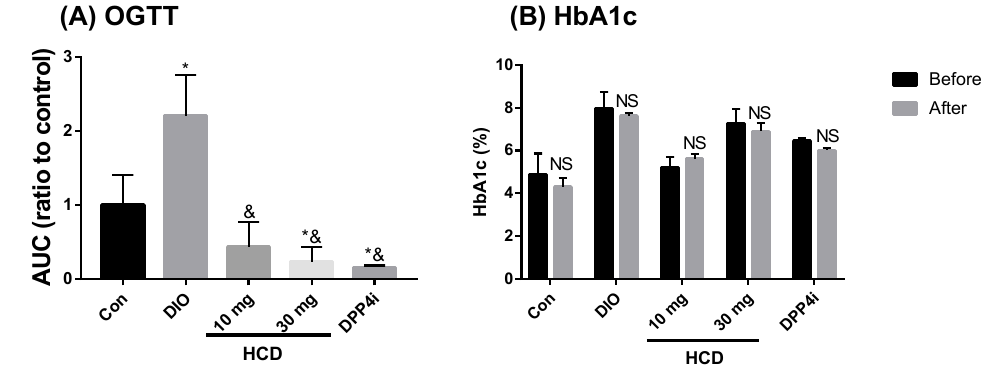
Figure 6. Insulin tolerance and glycated hemoglobulin (HbA1c) levels after long-term administration of natural compounds. DIO mice were fed with natural compounds for 5 weeks and insulin tolerance measured through ( A ) OGTT and ( B ) HbA1c levels. All results were mean ± SD from 6 individuals. * p < 0.05 meant significantly different as compared with Con ( A ) or before treatment ( B ), and & p < 0.05 represented significantly different from DIO mice.